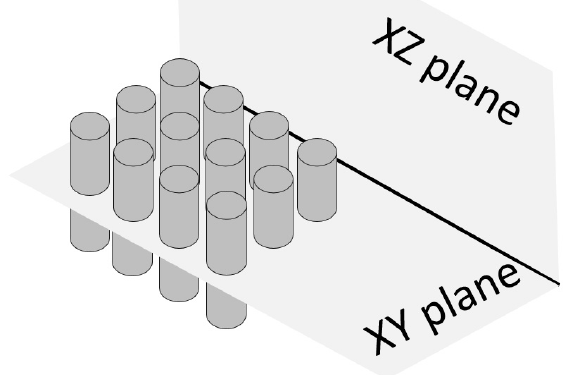
Appl. Sci. 2022 , 12 , x FOR PEER REVIEW Figure 7. Schematic view of the simulation planes. Figure 7. Schematic view of the simulation planes.